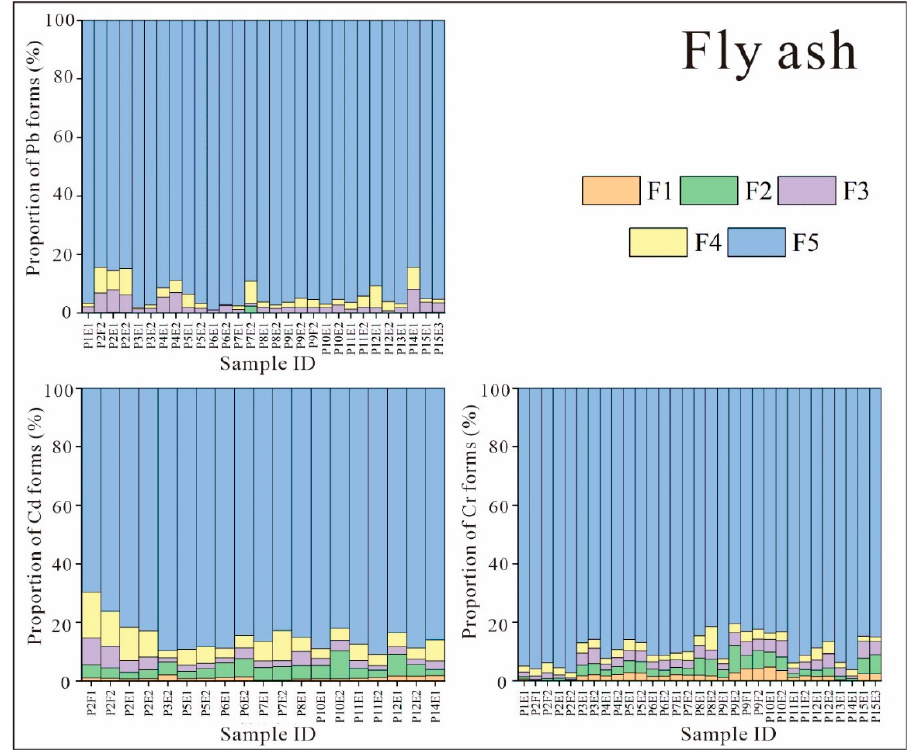
Figure 3. Proportions of heavy-metal forms in the FA samples from CFPPs in Guizhou Province